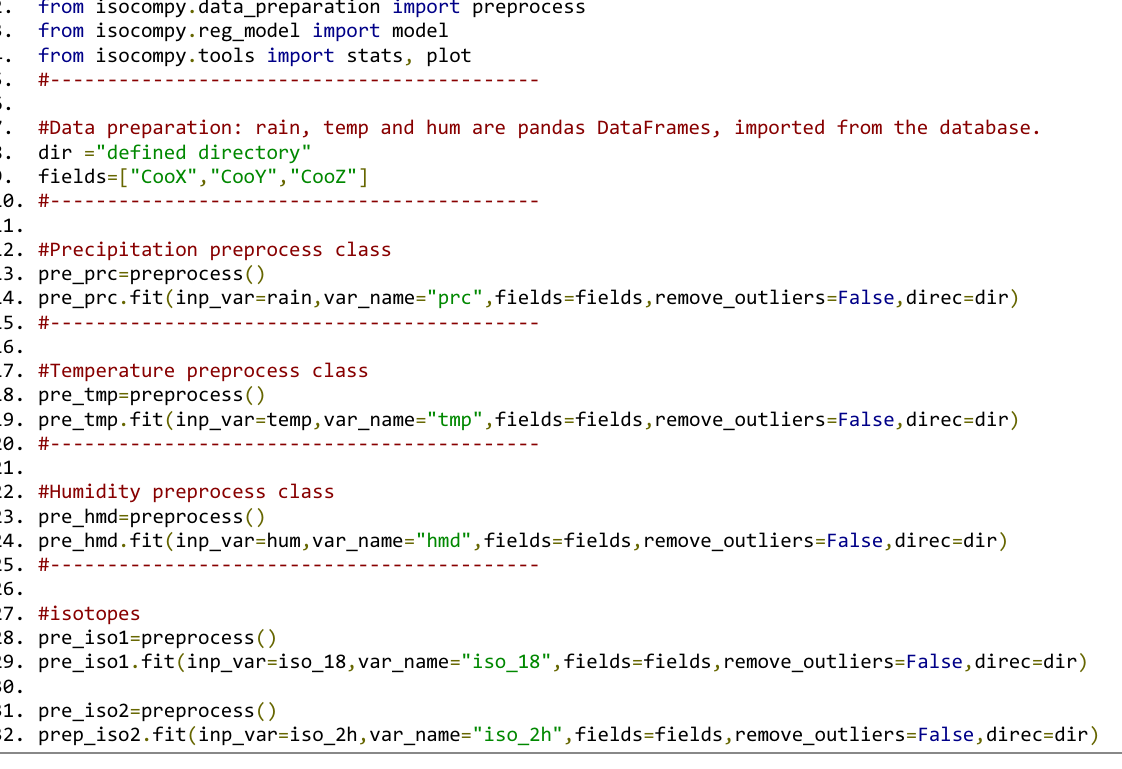
Figure 10. Isocompy data preparation. Location information (X, Y: coordinates; Z: altitude) is used to calculate the feature information in these positions . Preprocess classes are created for the precipitation, temperature, cumulative humidity, δ 18 O and δ 2 H of precipitation. Rain , temp and hum are panda dataframes that contain ID , Date and Value columns.